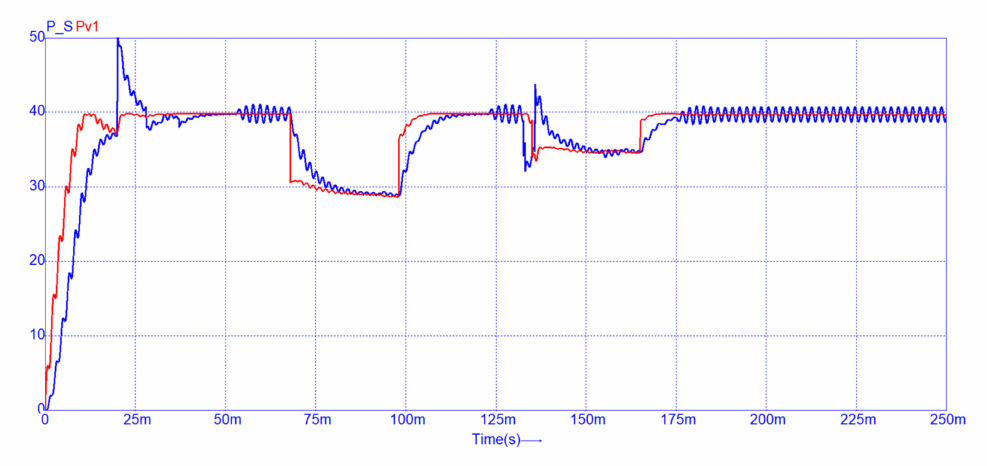
Figure 25. Simulation of input and output power during time according to the proposed scenario.